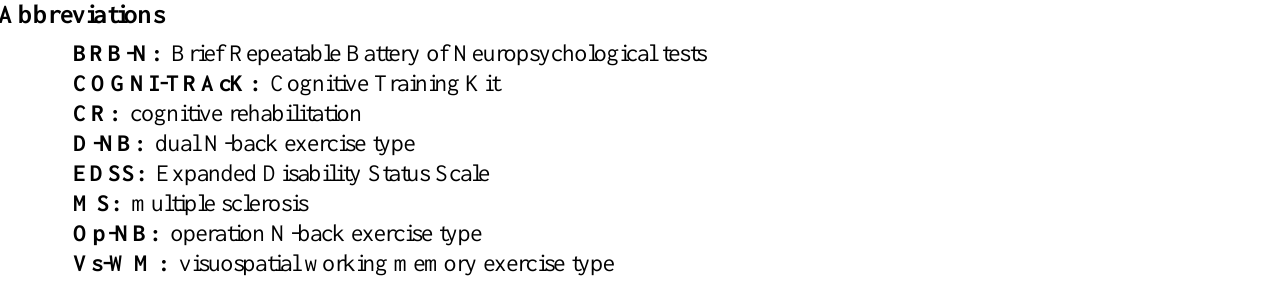
Vs-WM: visuospatial working memory exercise